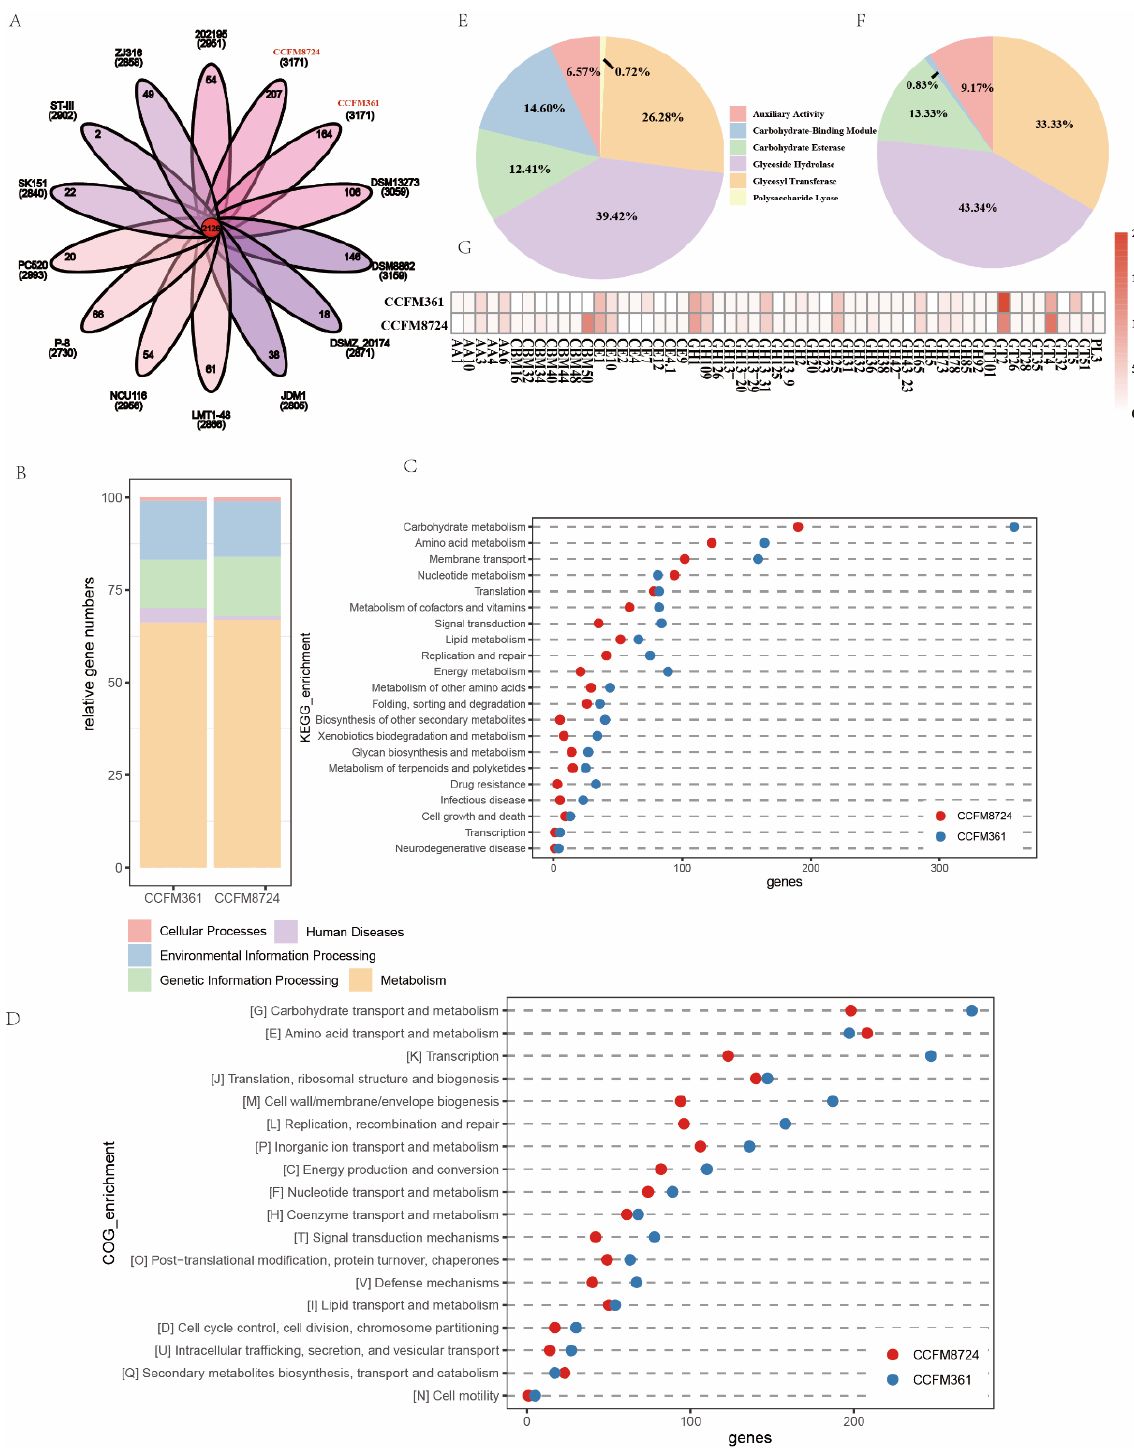
Figure 7. Comparative genome analysis of L. plantarum CCFM8724 and CCFM361. ( A ) Venn plot of shared and unique core genes distribution among L. plantarum strains. ( B ) The level I of Kyoto Encyclopedia of Genes and Genomes (KEGG) pathway enrichment analysis. ( C ) The level II of KEGG pathway enrichment analysis. ( D ) Enrichment analysis of Clusters of Orthologous Groups of protein (COGs) functional categories. ( E ) Genome-wide comparative distribution of carbohydrate-active enzymes (CAZy) in L. plantarum CCFM8724. ( F ) Genome-wide comparative distribution of CAZy in L. plantarum CCFM361. ( G ) Identification and quantification of gene count coding for different CAZy families of two strains. AA, auxiliary activity; CBM, carbohydrate-binding module; CE, carbohydrate esterase; GH, glycoside hydrolase; GT, glycosyltransferase; PL, polysaccharides.